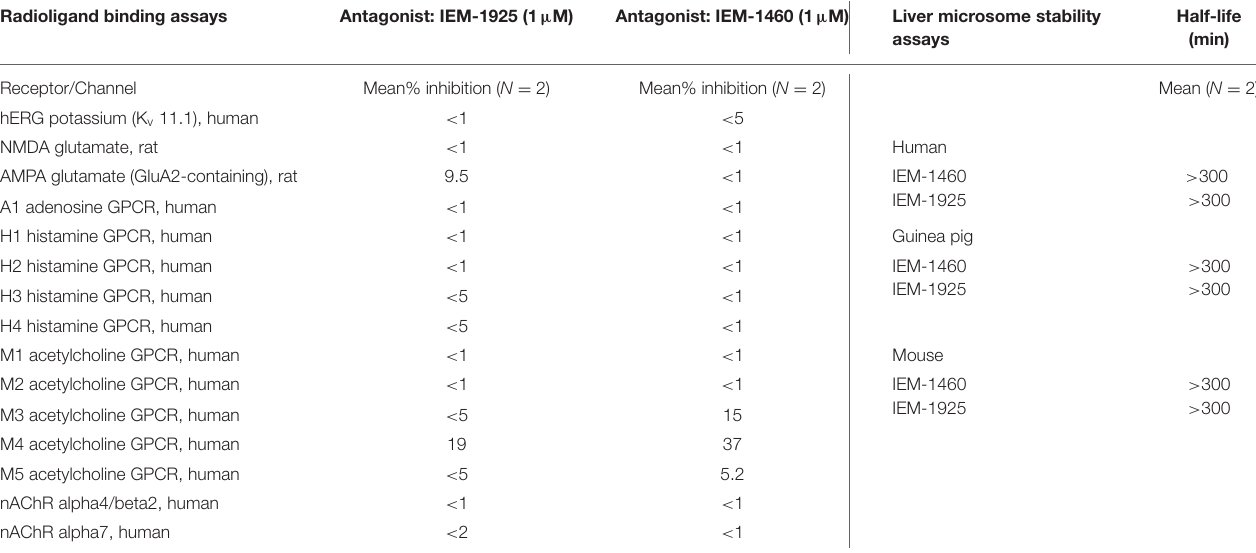
TABLE 1 | In vitro off-target binding assays and metabolic stability of IEM-1460 and IEM-1925. Radioligand binding